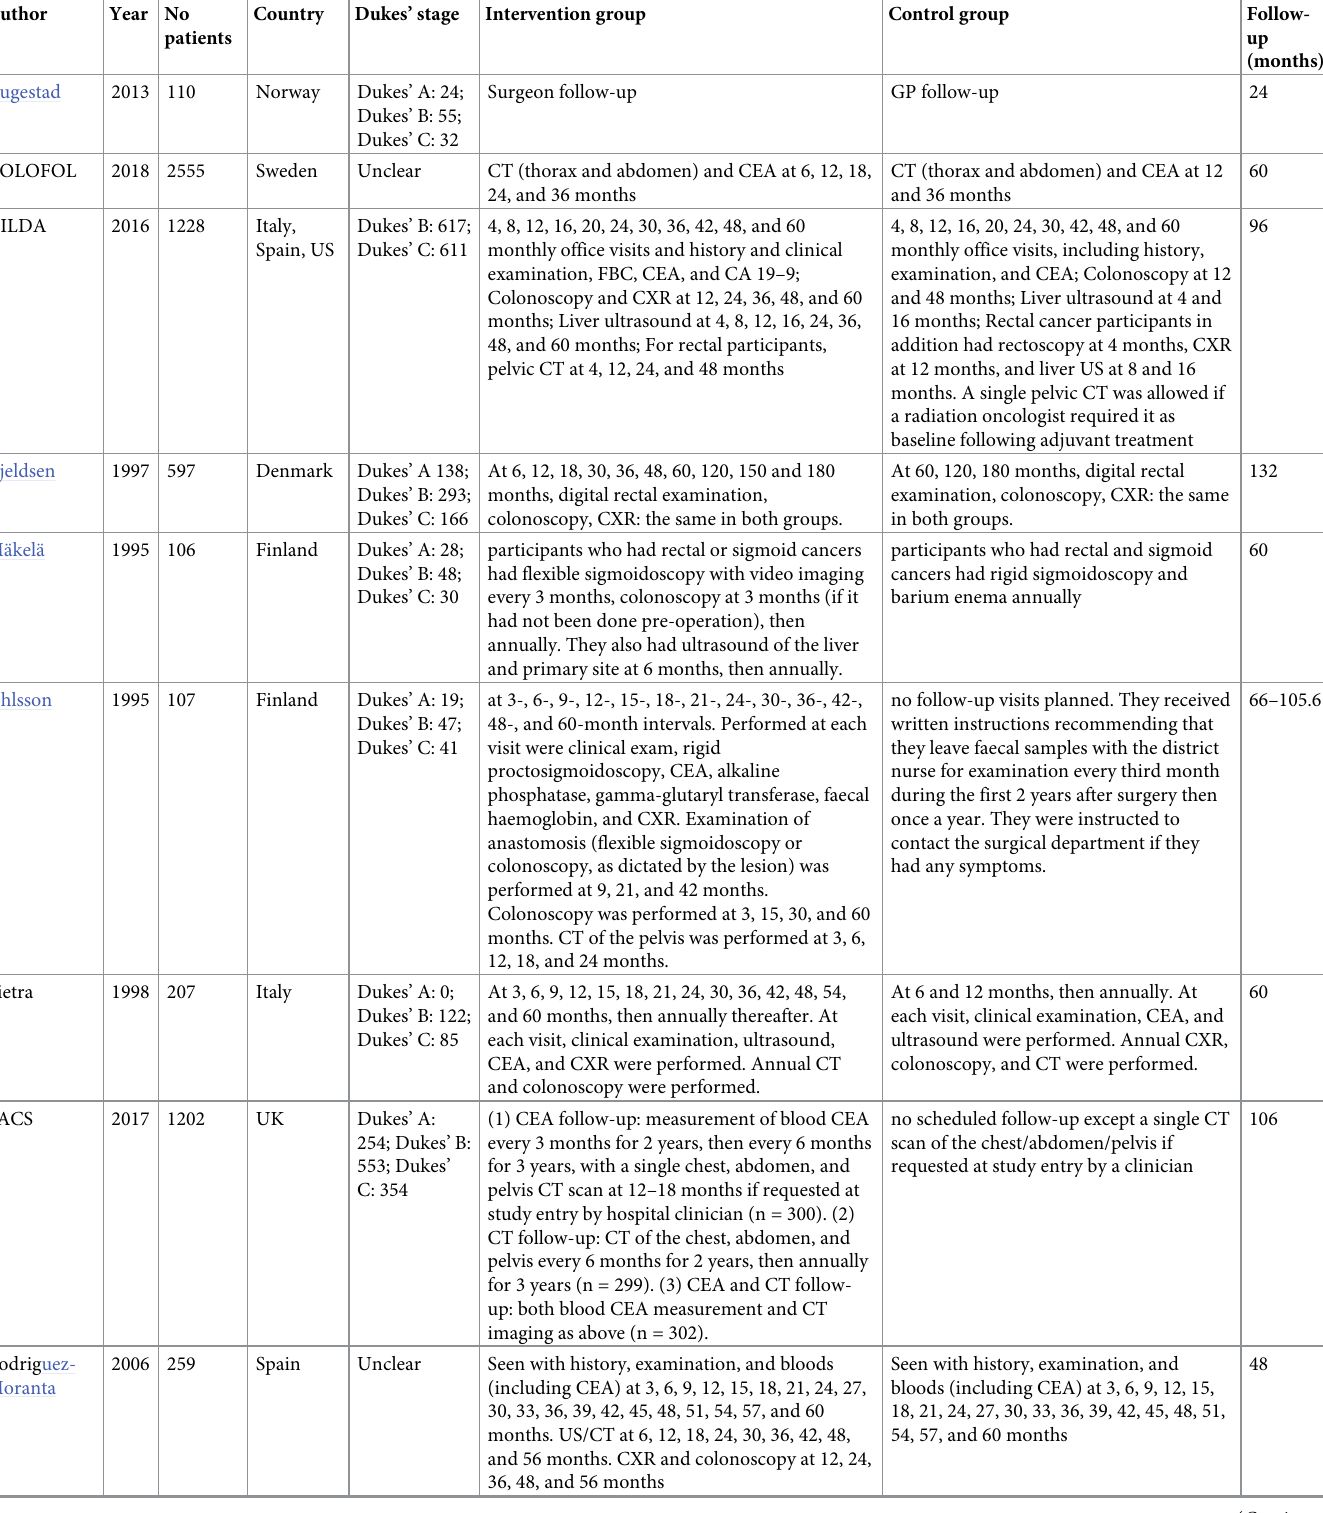
Table 1. The characters of included